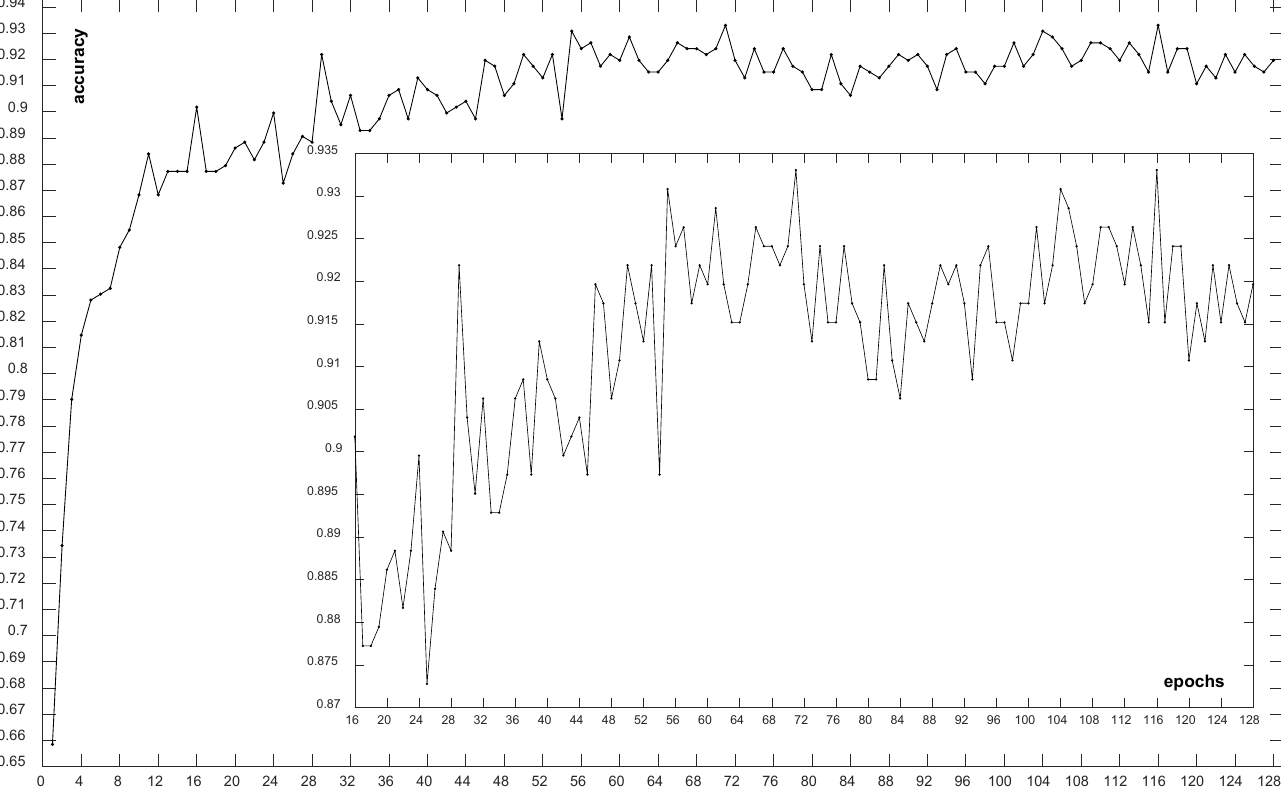
Fig. 10. The accuracy of the TLCNN with 384 and 192 filters in the 17 th and 20 th layers against the number of epochs. The best accuracy is first achieved after the 71 st epoch, whereupon the same accuracy is achieved after the 116 th epoch. Thus, the training process could have been stopped right after the 71 st